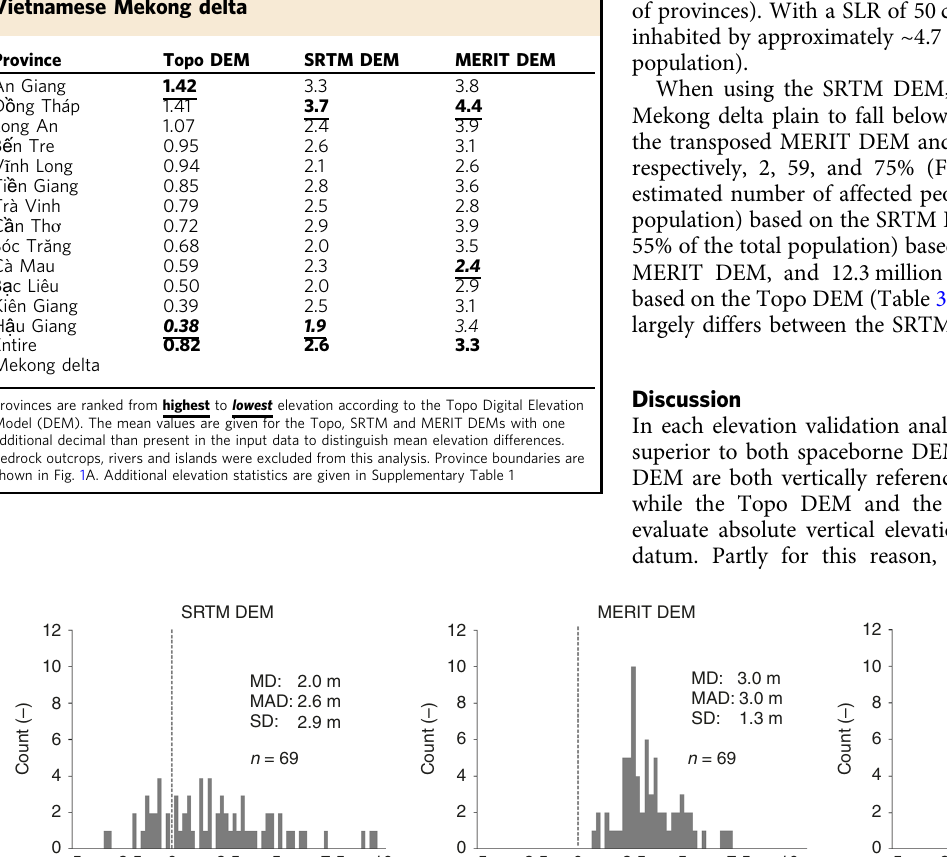
Table 1 Mean elevation of provinces and the whole